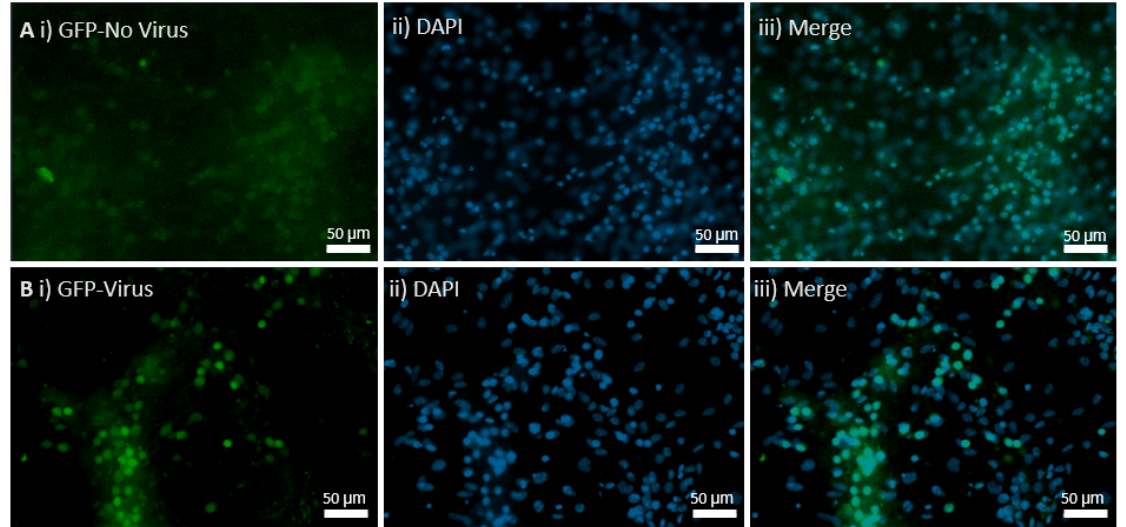
Figure 2. The transduction of hippocampal neuronal cultures from the MEN1 floxed mice with the virus, pNN.AAV.hSyn.HI.eGFP-Cre.WPRE.SV40. ( A ) Controls with no virus; ( i ) GFP signal in the absence of virus; ( ii ) DAPI for nuclear staining; ( iii ) merge with GFP and DAPI; ( B ) CKO with virus transduction by Cre AAV9; ( i ) GFP signal indicating virus transduction in the preparation with the Cre AAV9; ( ii ) DAPI for nuclear staining; ( iii ) merge with GFP and DAPI showing overlap in the neurons expressing GFP and DAPI.